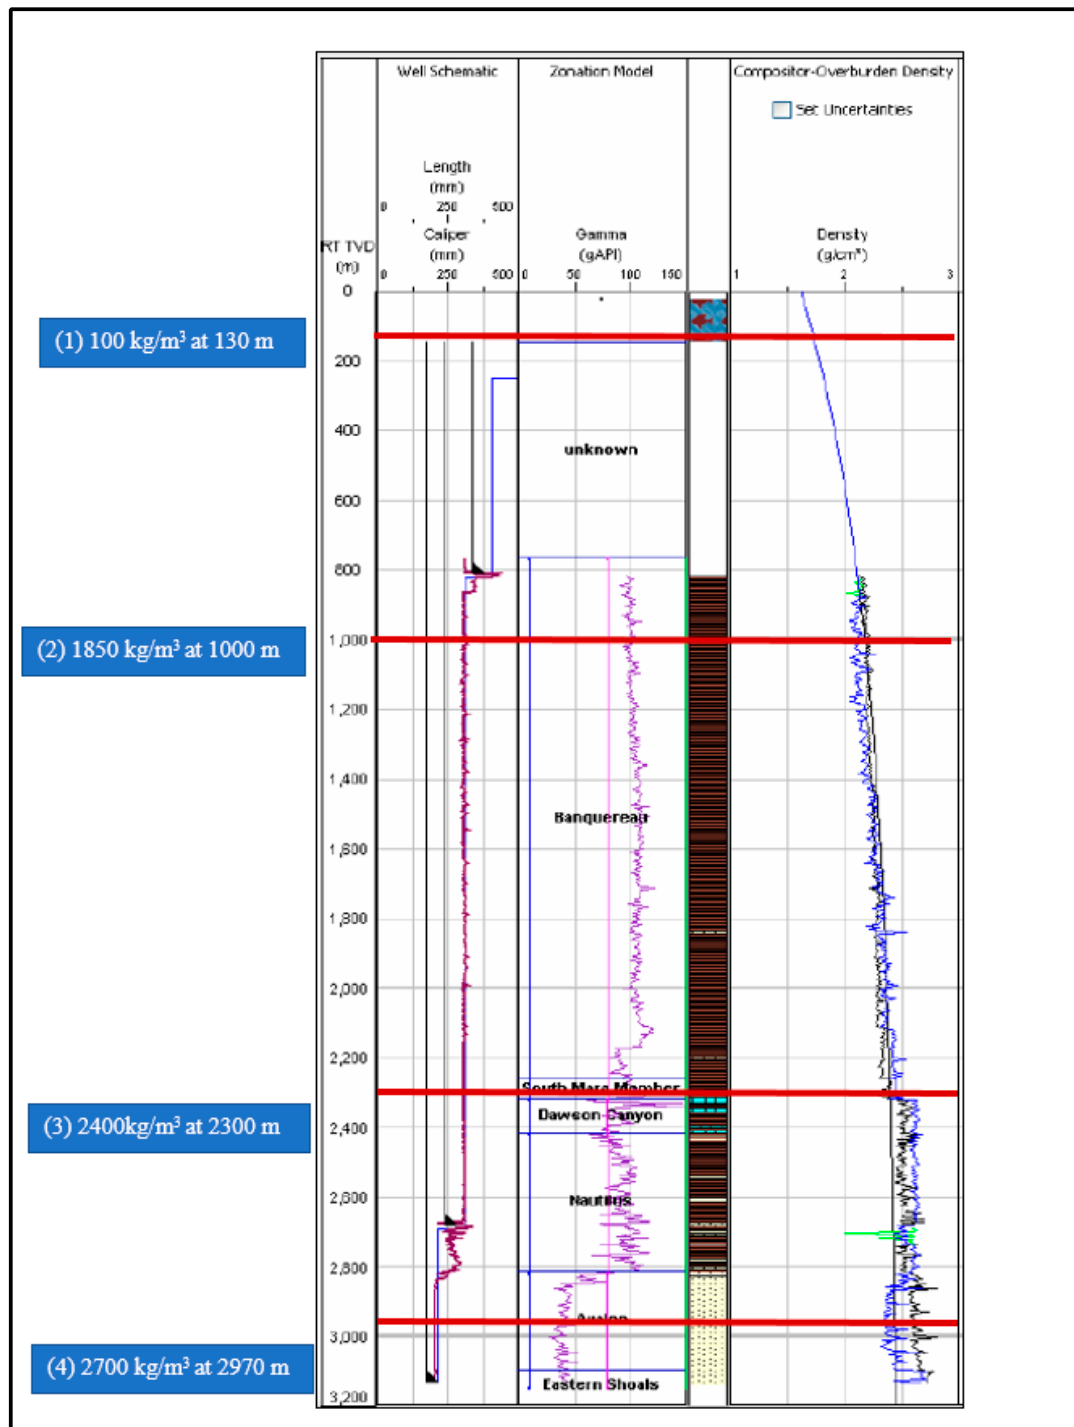
Figure 22. Bulk density ( ρ b) recorded by the log of Well N-8 (blue line).